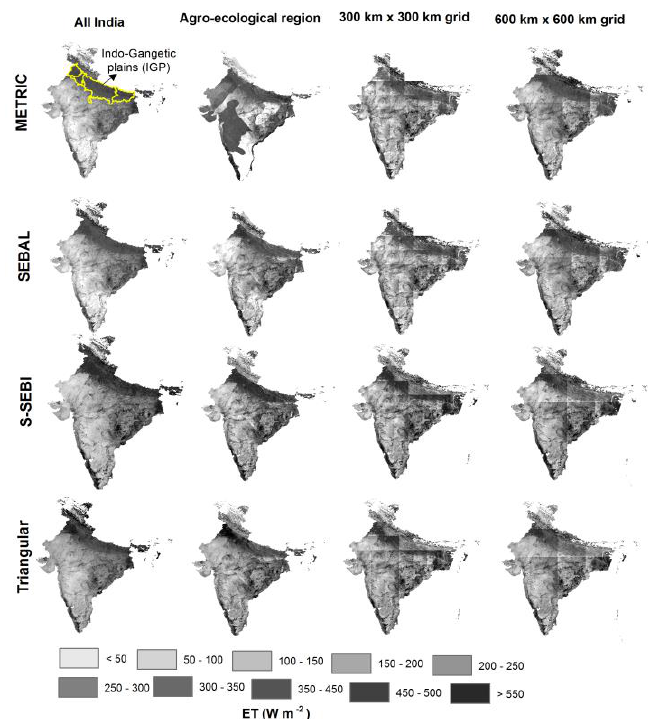
Figure 3. ET maps for March 12, 2005 from the four contextual based SEB models using the four spatial